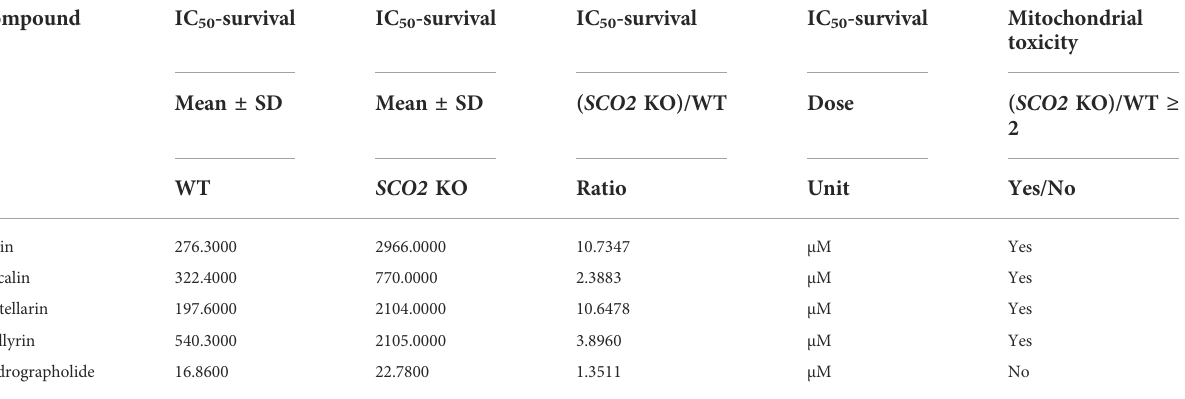
IC 50 ATP-Glu/Gal ≥ 2 indicates potential mitochondrial toxicity.